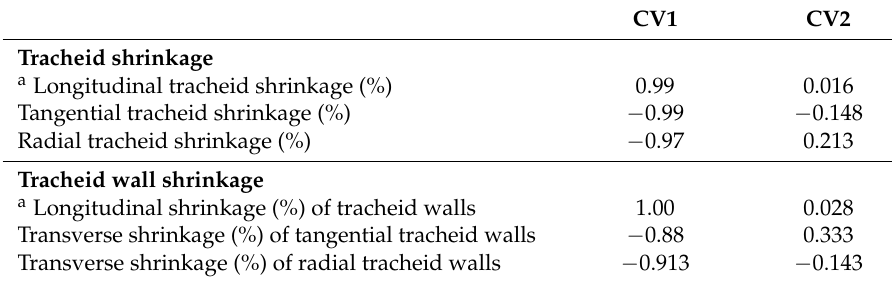
Table 2. Canonical discriminant analysis (CDA) structure coefficients for the first two canonical variates of the correlations between the shrinkage of tracheids and between the shrinkage of the tracheid walls in three directions, in the four corewood types of the three